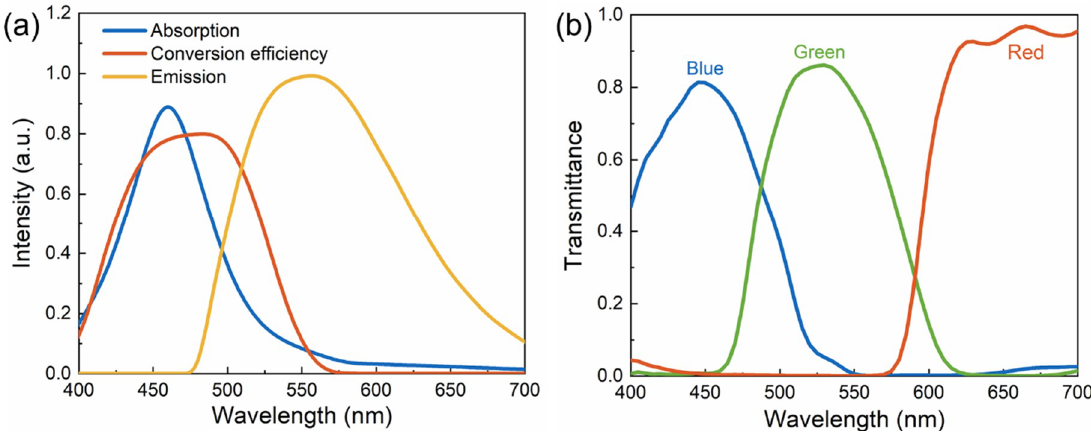
Figure 2. ( a ) The absorption spectrum, emission spectrum and color conversion efficiency of the employed yellow phosphor. ( b ) Transmittances of conventional color filters.